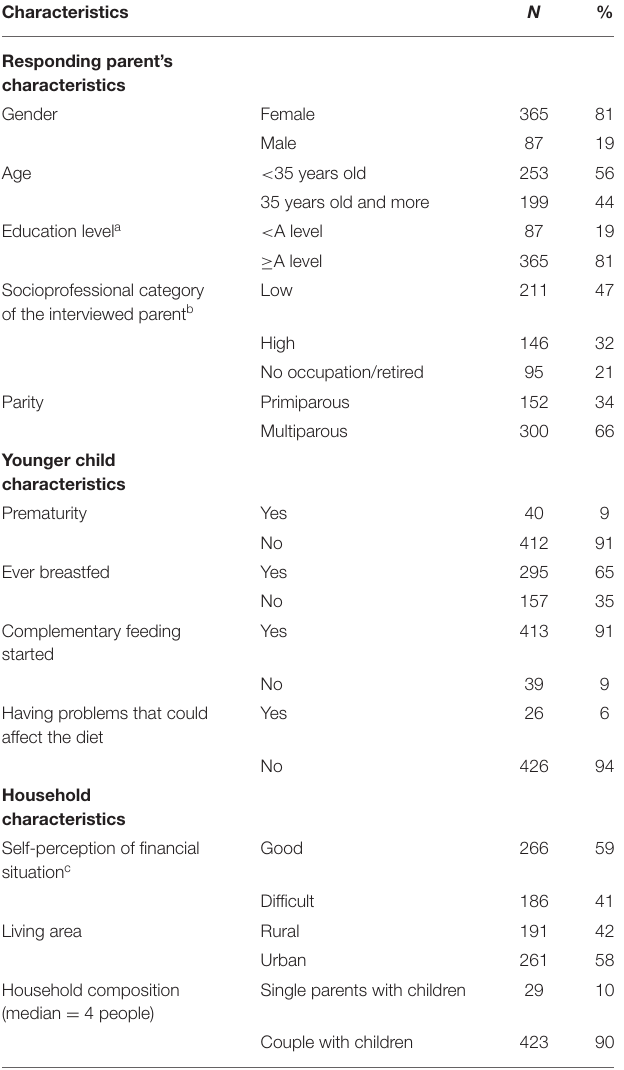
TABLE 2 | Characteristics of the sample of French parents who responded to the survey at T0 and T1 ( n = 452).